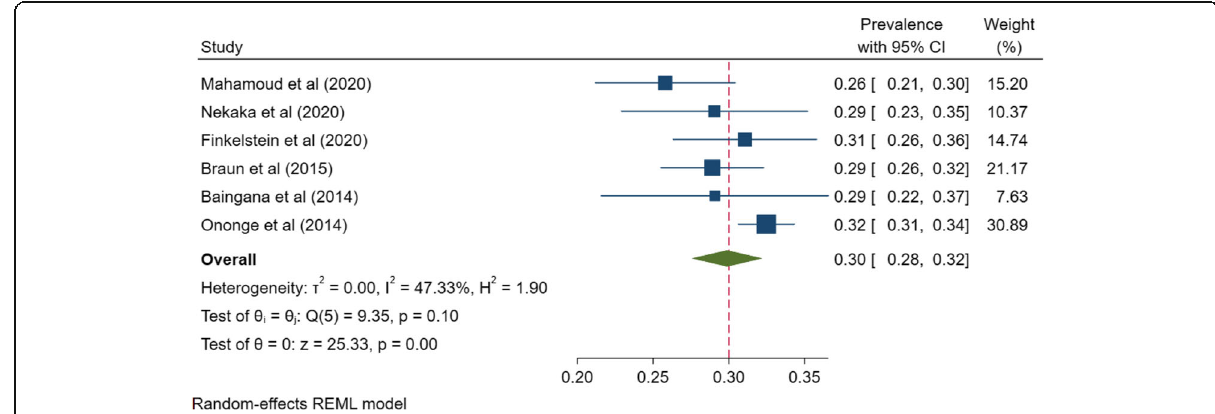
Fig. 4 Sensitivity analysis of studies falling within the funnel